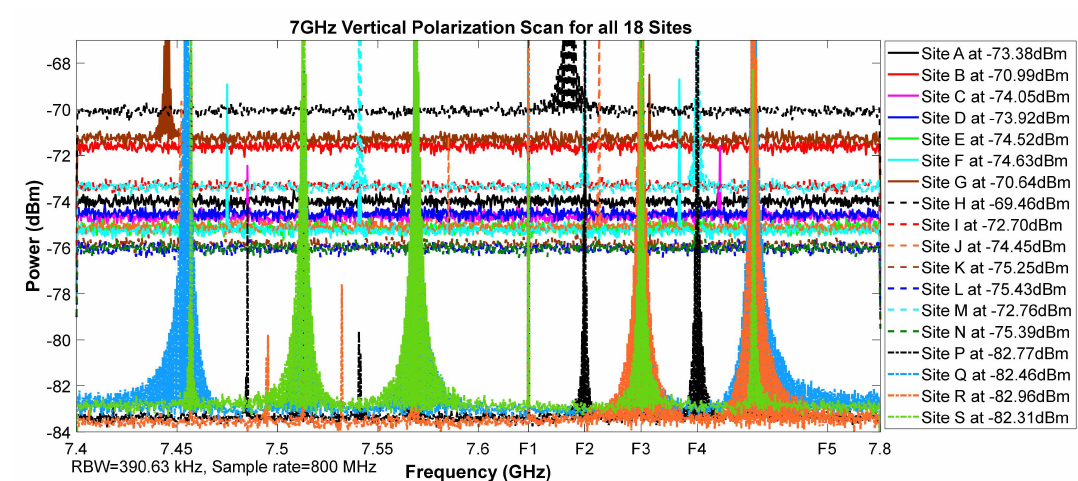
Figure 8. 7 GHz vertical polarization scan for all 18